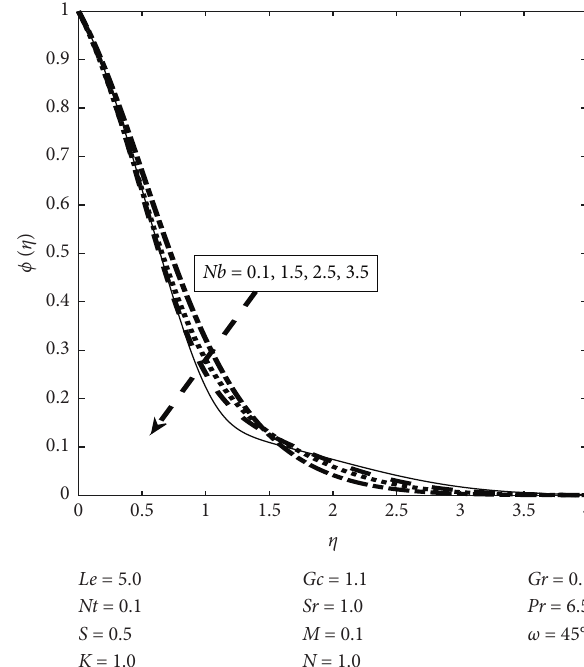
Figure 13: Temperature profile for several values of Nt .